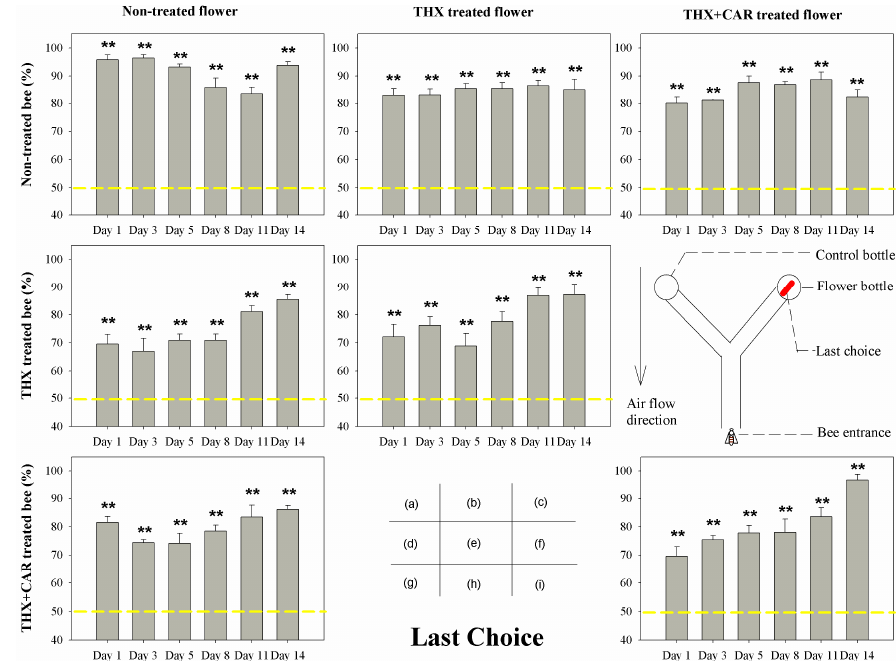
Figure 3. The last choice of bee orientation behavior in Y maze treated with thiamethoxam (THX) and thiamethoxam + carbendazol mixture (THX + CAR). The X-axis presented the time post-treatment (Day). The red bold line in diagram (f) showed the last choice of a bee to enter the flower bottle. The yellow dash line showed the reference line of 50%, ** presents great significant difference ( p < 0.01), ns means no significant difference ( p > 0.05).